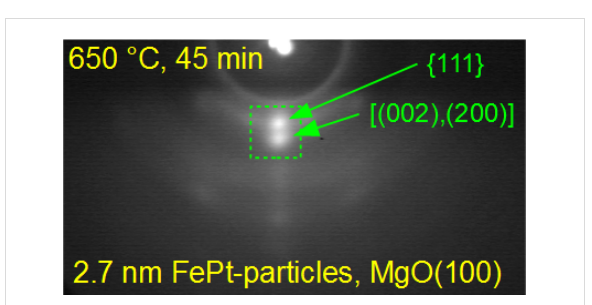
Figure 9: RHEED pattern of 2–3 nm FePt particles on MgO(001), re- corded with an beam energy of 25 keV after annealing at 650 °C for 45 min clearly shows texture formation with spots on the (111) and (200), (002) Debye–Scherrer rings.